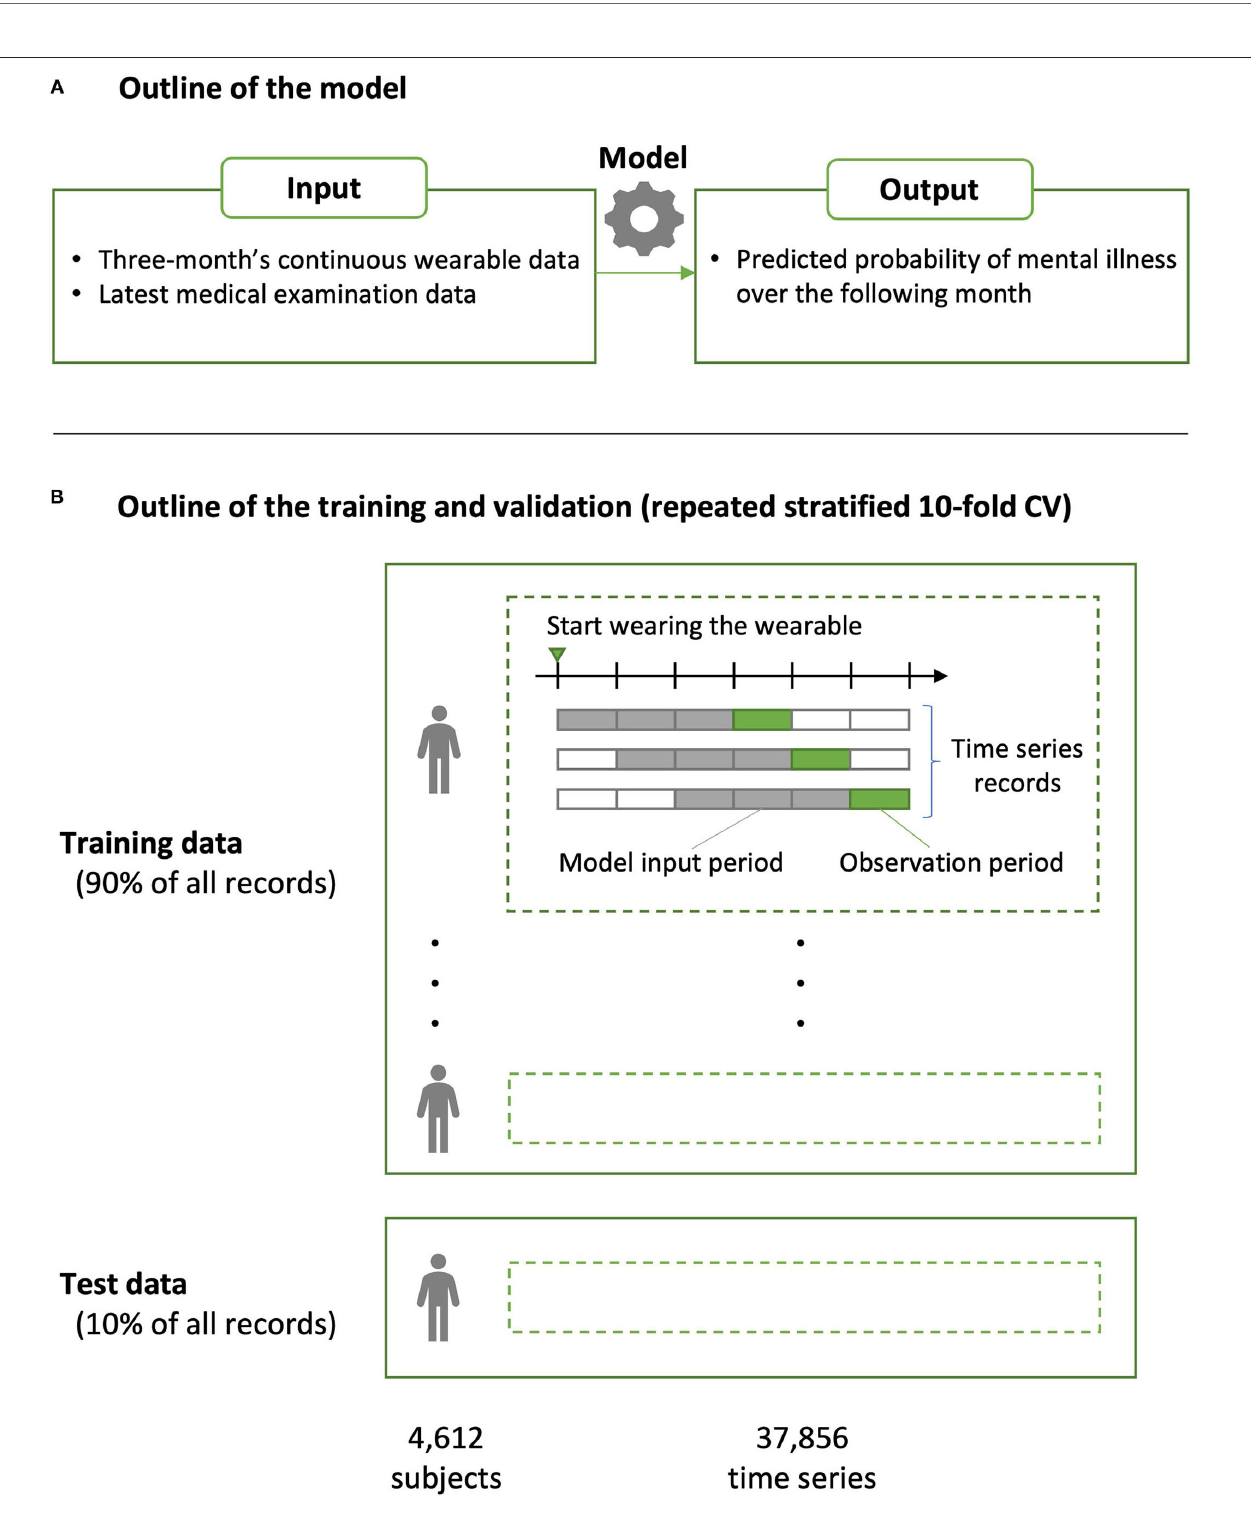
FIGURE 1 | Overview of the predictive model construction and validation. (A) The predictive model was built using the XGBoost algorithm. The inputs to the model were 3-month’s continuous wearable data and those of the medical examinations closest to (i.e., within or prior to) that period; the output was the presence or absence of mental illness over the following month, which was defined based on insurance claims data. (B) Predictive performance was evaluated using a repeated stratified 10-fold cross validation (CV). Because the dataset included different time series from a single person, partition division was conducted to avoid including the same person in the model training and testing data in each fold (group